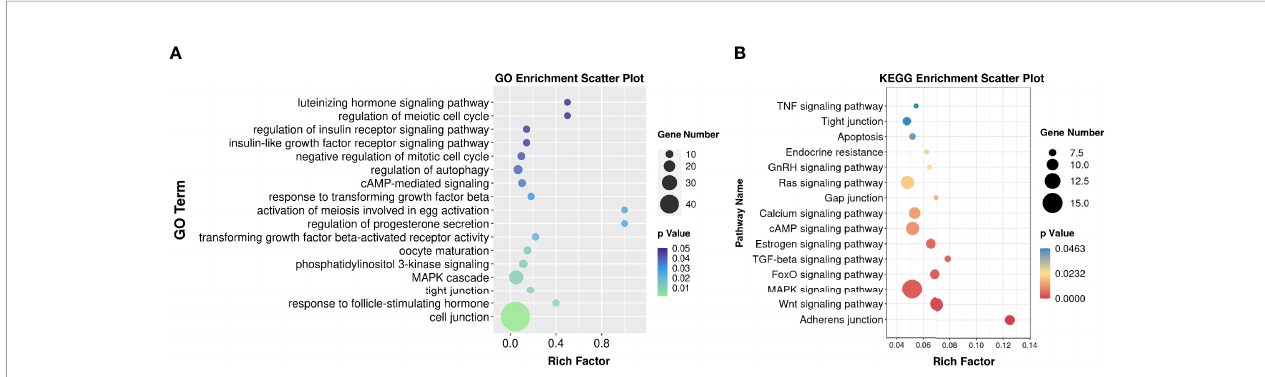
FIGURE 2 | Functional enrichment analysis. (A) Gene Ontology (GO) bubble chart for DEG enrichment. (B) Kyoto Encyclopedia of Genes and Genomes (KEGG) bubble chart indicating the enrichment of DEGs. Rich factor is de fi ned as S gene number divided by B gene number. “ S ” was annotated as the number of genes with signi fi cant difference in speci fi c GO/KEGG categories; “ B ” was the number of genes for a speci fi c GO/KEGG ( N MF = 6, N OEM = 5).